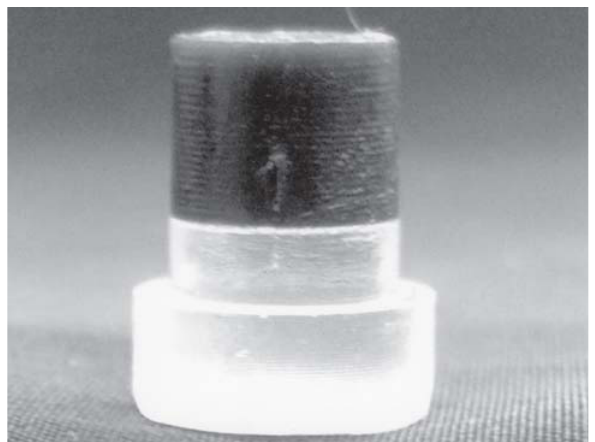
FIGURE 2- Wax pattern above the epoxy resin